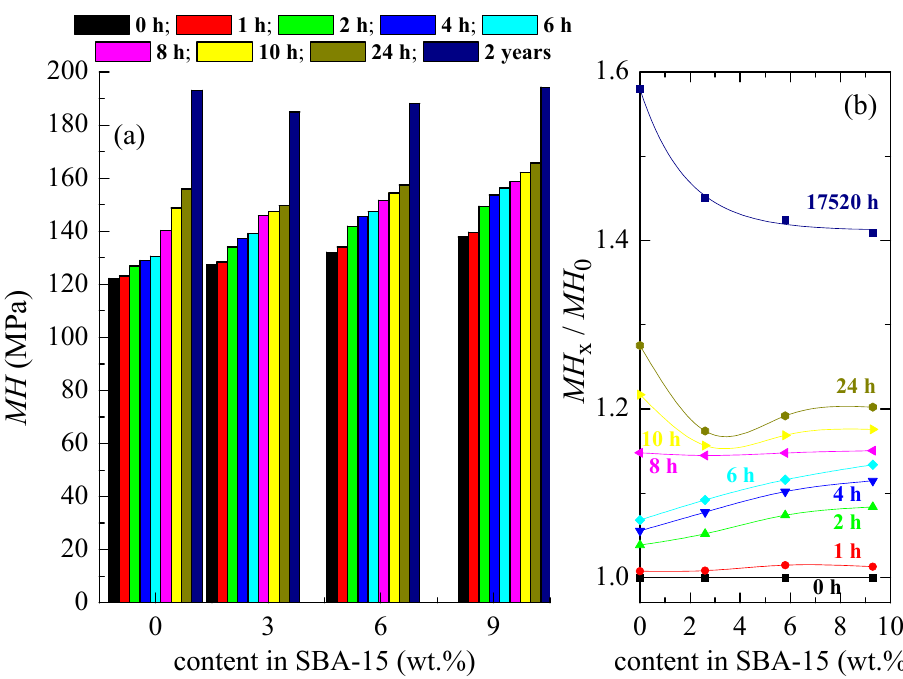
Figure 12. ( a ) Microhardness (MH) dependence on SBA-15 content at different aging times for neat PLA and its composites with silica processed from the melt. ( b ) Variation with silica content of the ratio between the actual MH and the initial value at each sample for the several analyzed aging times.